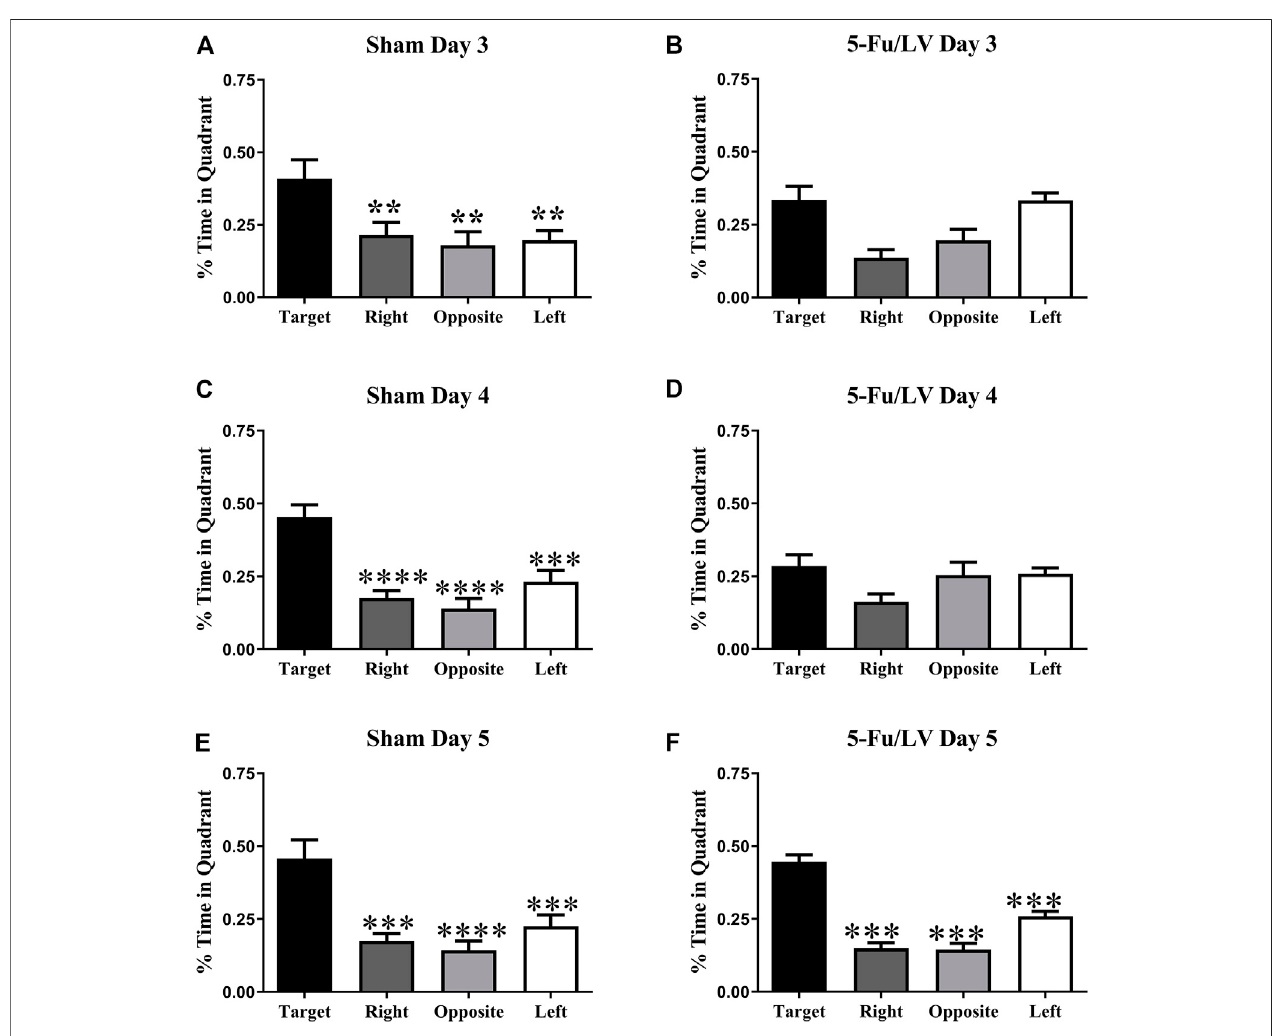
FIGURE 4 | Percent of total time spend in each quadrant for the MWM task probe trial on day 3. Sham mice spent signi fi cantly more time in the target quadrant compared to the other three quadrants [Fig. (A) : Day 3], [Fig. (C) : Day 4], [Fig. (E) : Day 5]. 5-Fu/LV treated mice spent their time randomly searching quadrant [Fig. (B) : Day 3], [Fig. (D) : Day 4]. However, 5-Fu/LV spent signi fi cantly more time in the target quadrant day 5 [Fig. (F) ]. Average ± SEM ( n (cid:1) 15 per treatment Group) * p < 0.05, ** p < 0.01, *** p < 0.001, **** p <